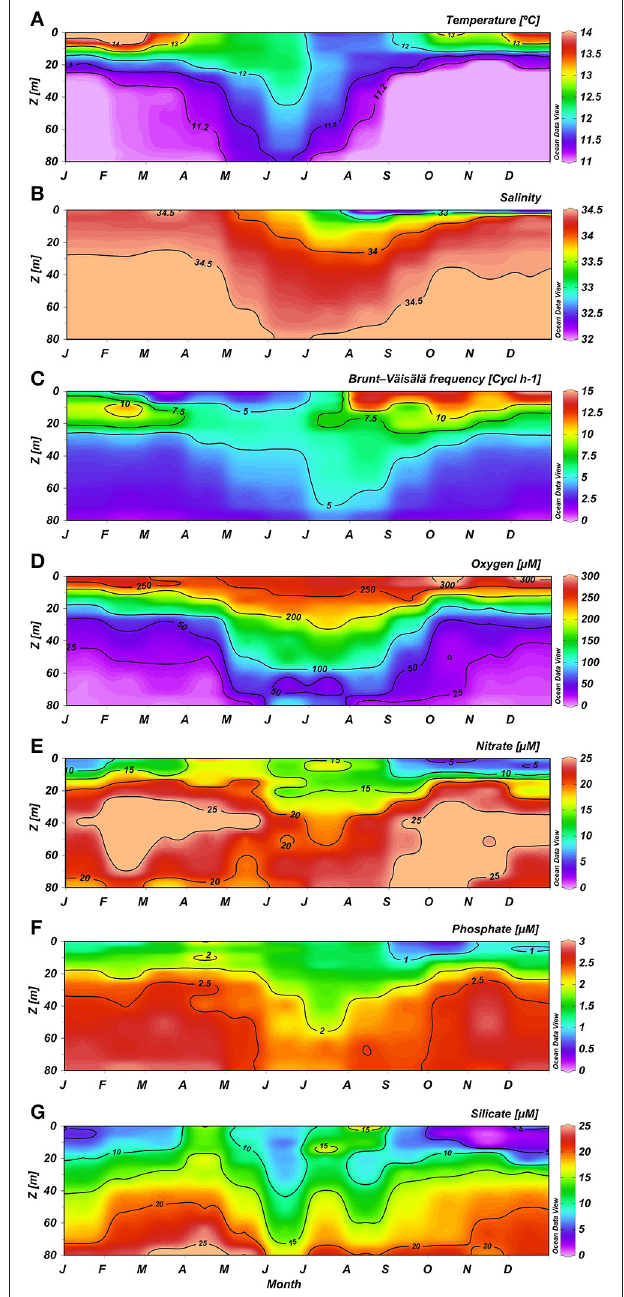
FIGURE 3 | Mean climatology for Temperature (A) , Salinity (B) , Brunt-Väisälä frequency (C) , Oxygen (D) , Nitrate (E) , Phosphate (F) , and Silicate (G) at ST18.